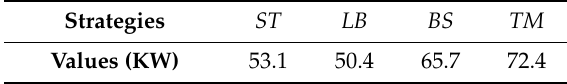
Figure 6. Detailed power consumption under four strategies (cloudy): ( a ) static method ( ST ); ( b ) load balancing distribution over time (LB) ; ( c ) best effort strategy ( BS) ; ( d ) thermal-aware workload management ( TM ). Table 4. Values of actual solar power utilized on a sunny